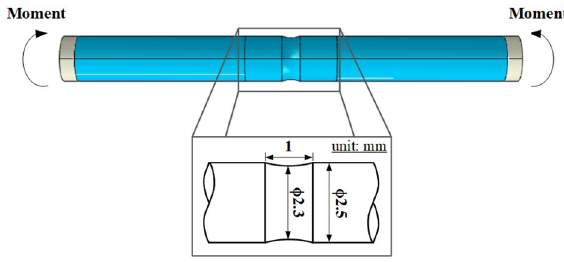
Figure 29. FE model of rotary bending fatigue